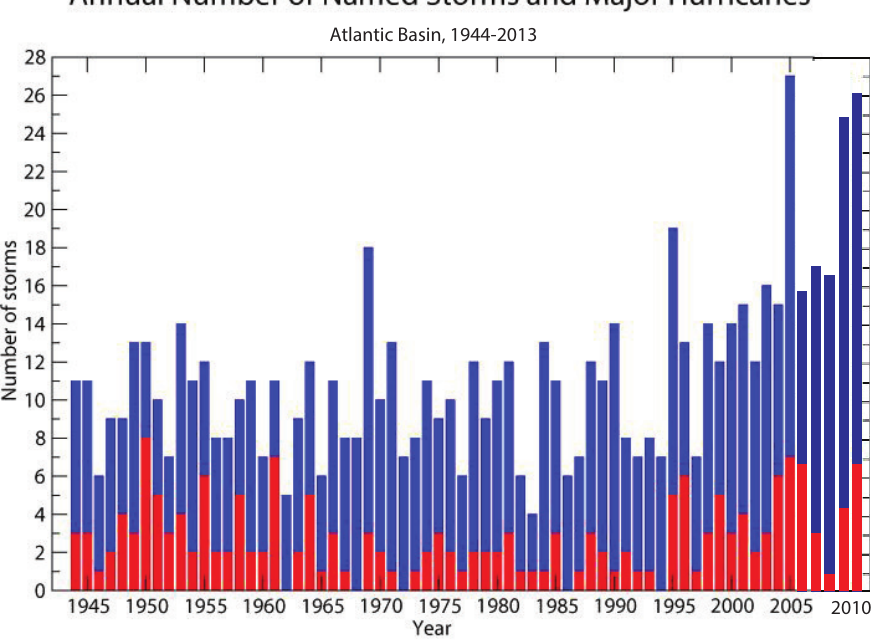
Figure A2. Annual number of named tropical storms and major hurricanes: Atlantic, 1944–2013; named tropical storms are depicted in blue and major hurricanes are depicted in red (source: